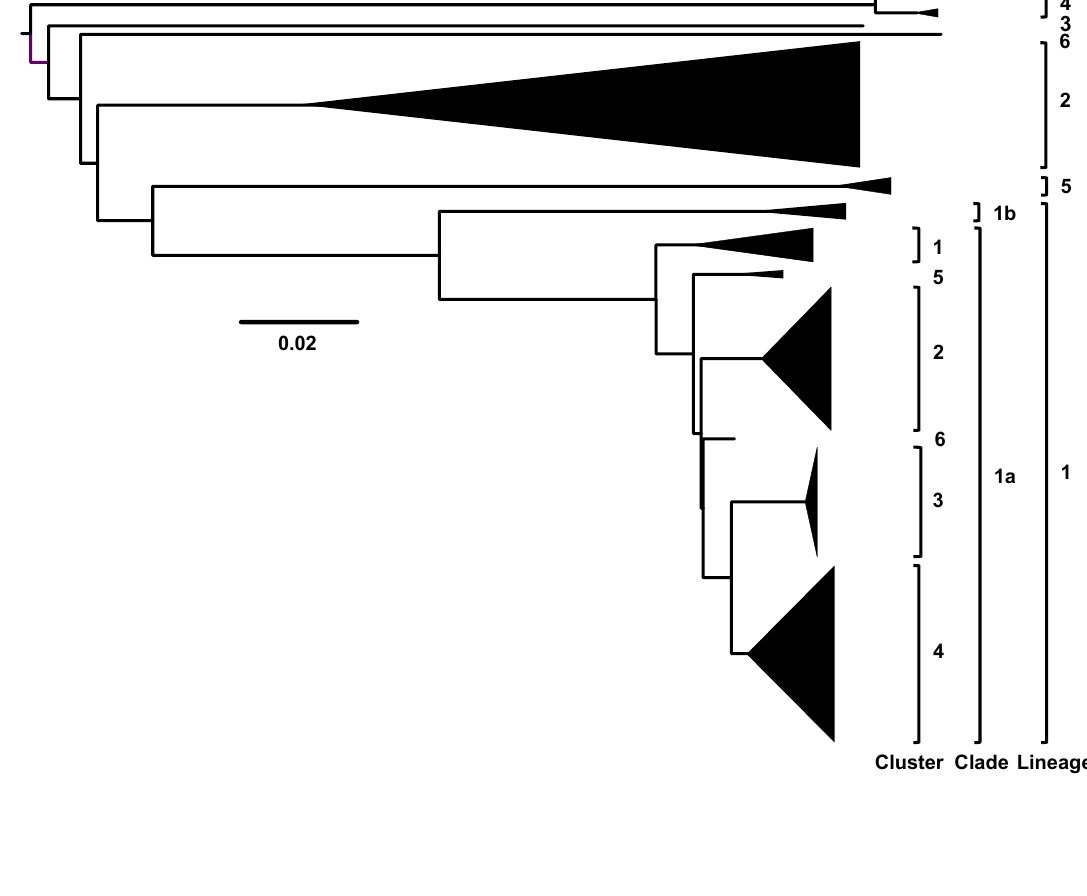
Figure 1. Neighbor-joining phylogenetic tree, using condensed, simplified branches that depicts the Lineages 1–6 of West Nile virus. Indicated phylogenetic groupings are defined based upon the genetic distance ( i.e ., % nucleotide divergence) for isolates which cluster within Lineages 1–6 ( ≥ 20%), Clades 1a and 1b (12.7%–20.8%) of Lineage 1, and Clusters 1–6 ( ≤ 5.4%) of Lineage 1a. Lineages 1 and 2 are the most geographically dispersed and include both endemic and epidemic strains associated with outbreaks of neurologic disease in humans, horses and birds in the Americas, Europe, Africa and the Middle East. Strains circulating in the Americas belong to Cluster 4 of Lineage 1a, as defined by May et al . (2011)